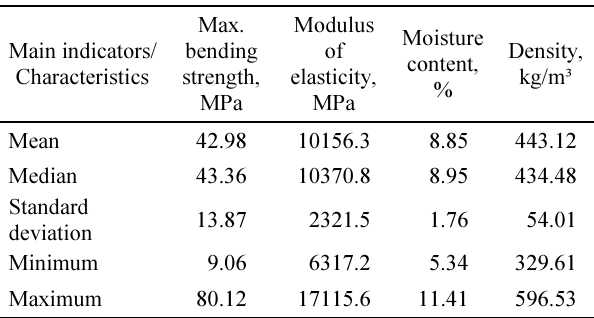
Table 1. Characteristics of the statistical indicators